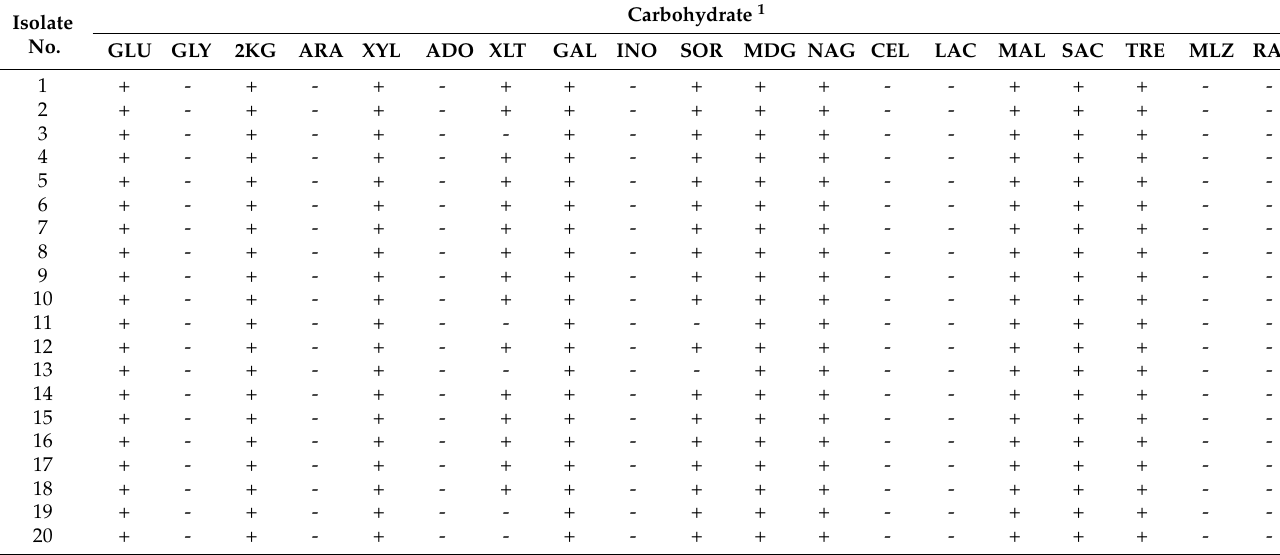
Table 1. API 20C Aux results for C. albicans